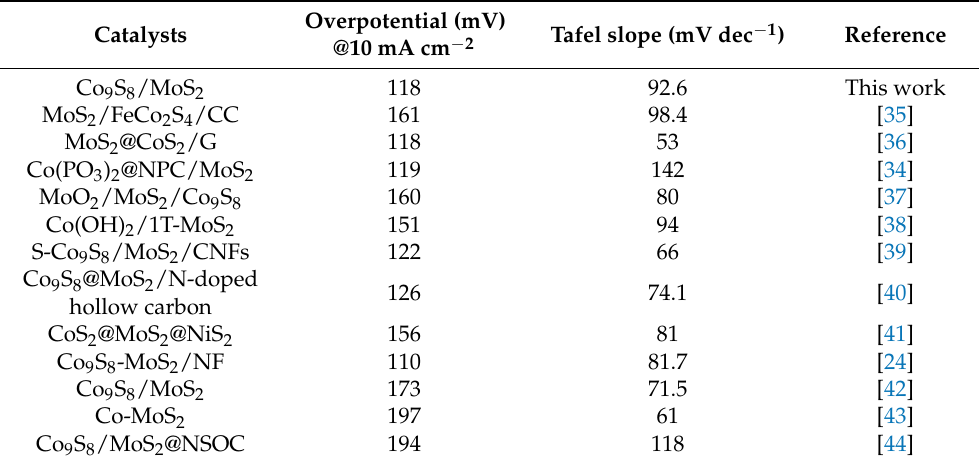
Table 1. Comparison of HER activity for Co 9 S 8 /MoS 2 in this work and other reported electrocatalysts (1 M